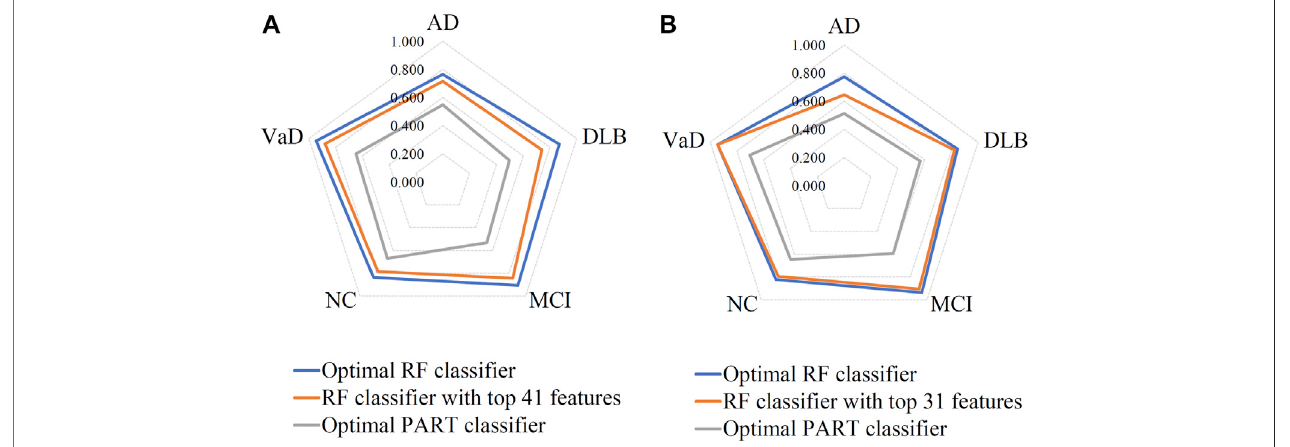
of 0.713 ( Table 3 ). Its performance on fi ve classes is shown in Figure 4B . Clearly, it was inferior to the optimal RF classi fi er.